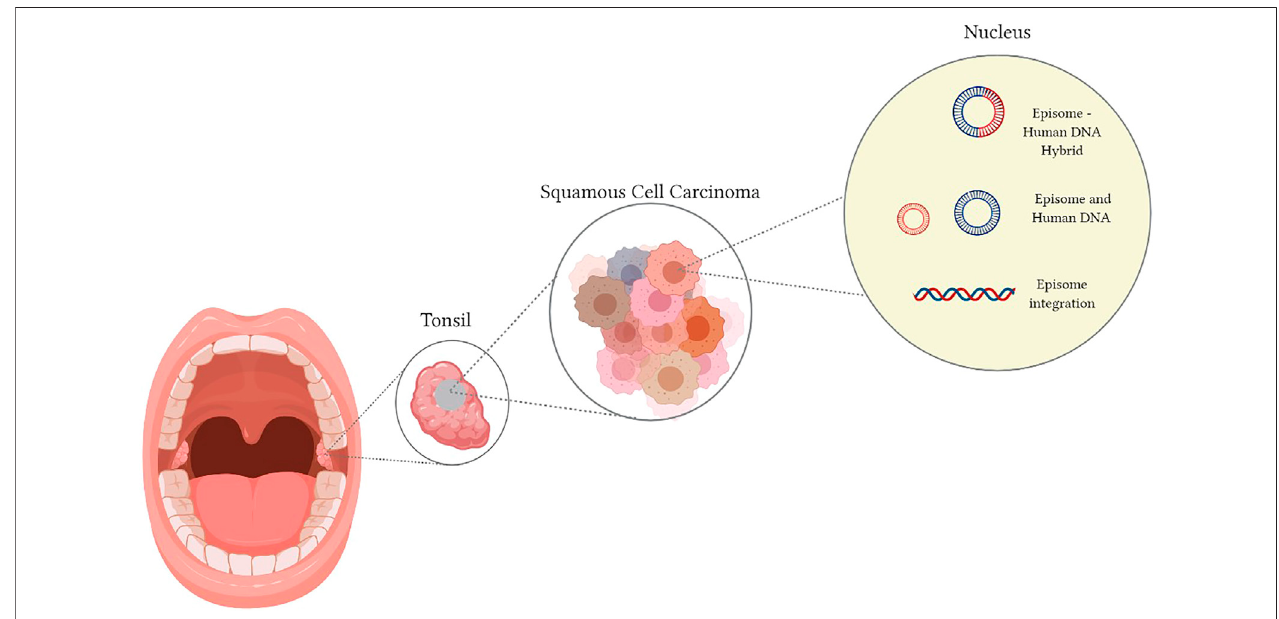
FIGURE1| HumanPapillomaVirustransmissionintothehostnucleus canresultin (A) ViralDNAintegration, (B) ahybridofconjoinedviral-DNAandhostDNA, (C) independent viral-DNA, not integrated or linked with the host DNA.